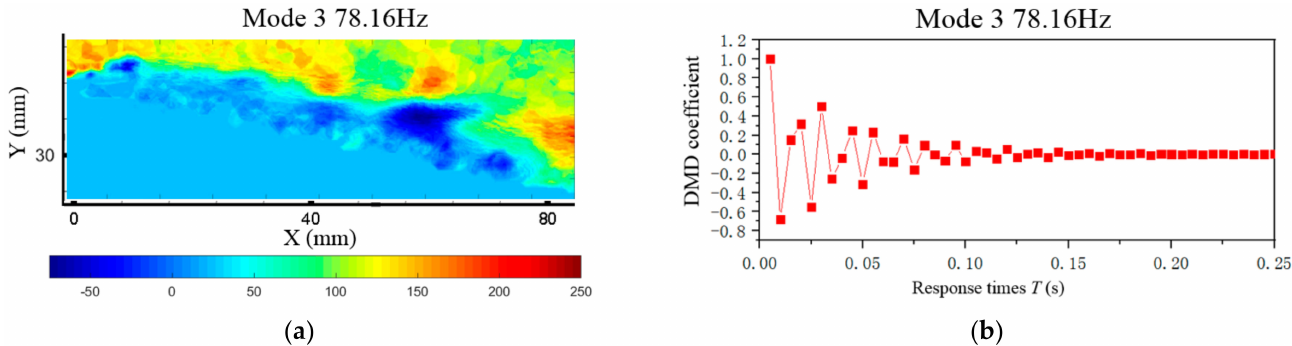
Figure 15. Third − order mode PSD = 78.16 Hz. ( a ) Decomposition results of the PIV velocity nephogram modal DMD in the Region A; ( b ) the DMD modal coefficient curve in the Region